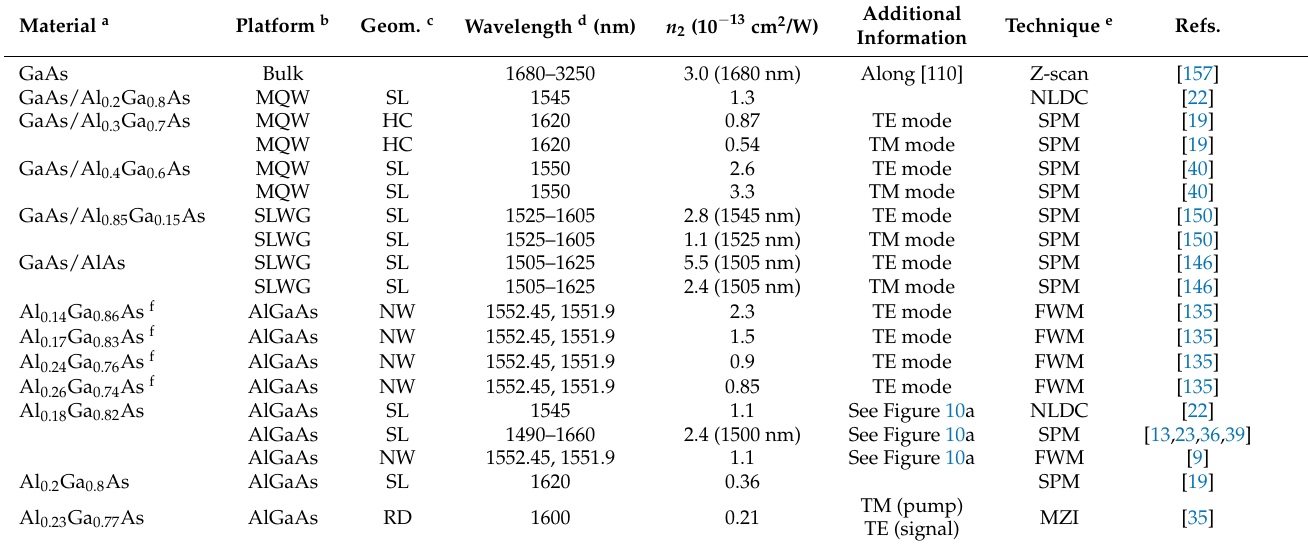
Table 5. Nonlinear refractive indices measured in (Al)GaAs